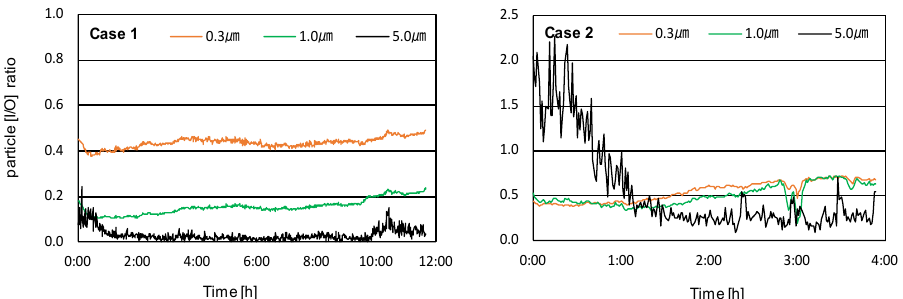
shown in Table 4.